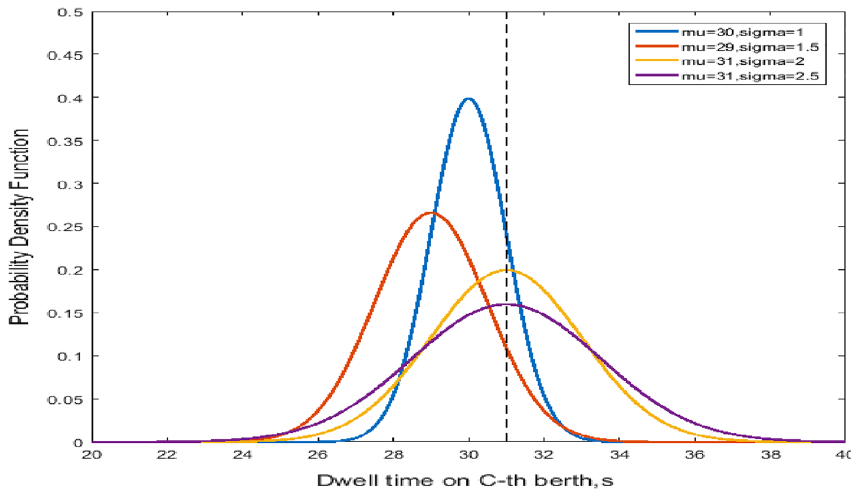
Figure 2. Normal distribution of dwell time at the C-th Berth.